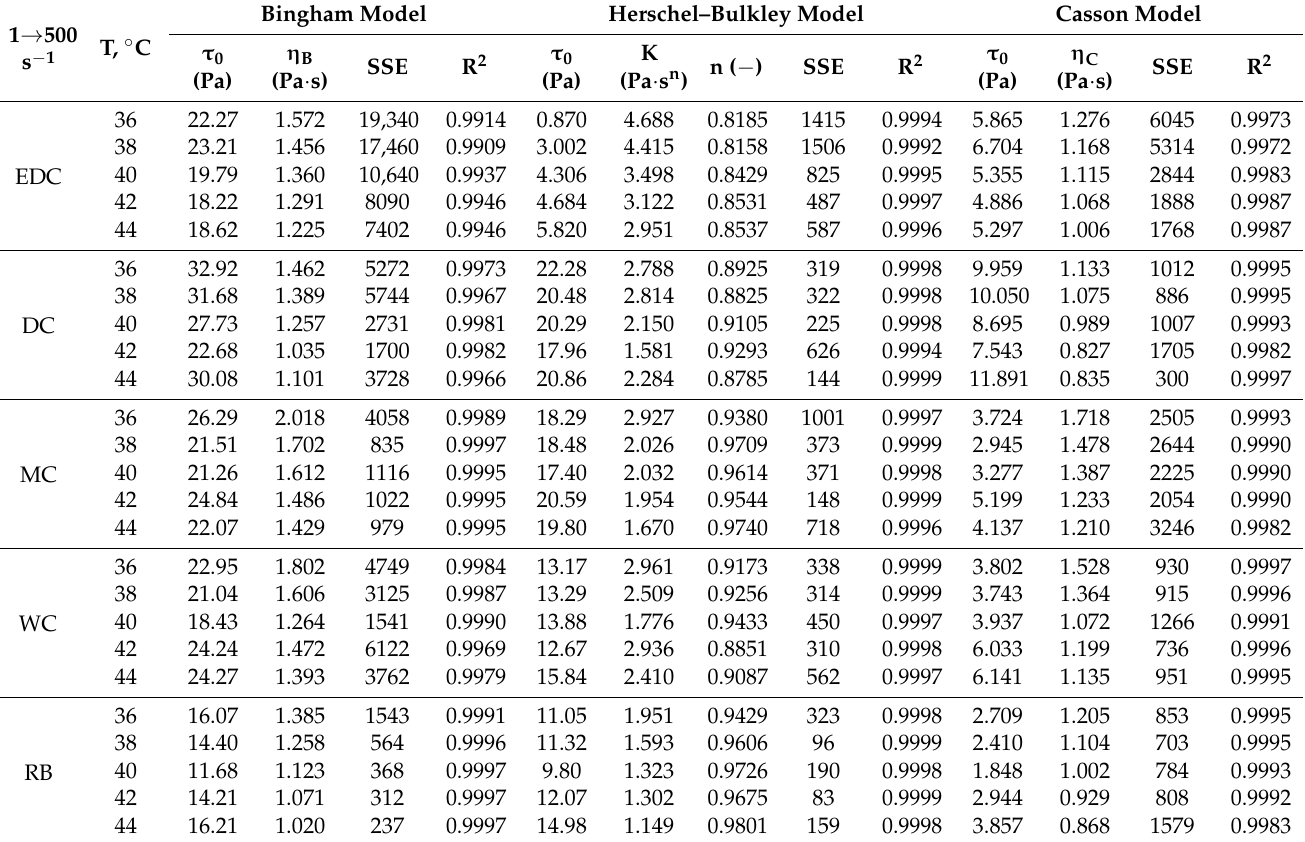
Table 3. Coefficients of the rheological models with an increasing shear strain rate ( n =